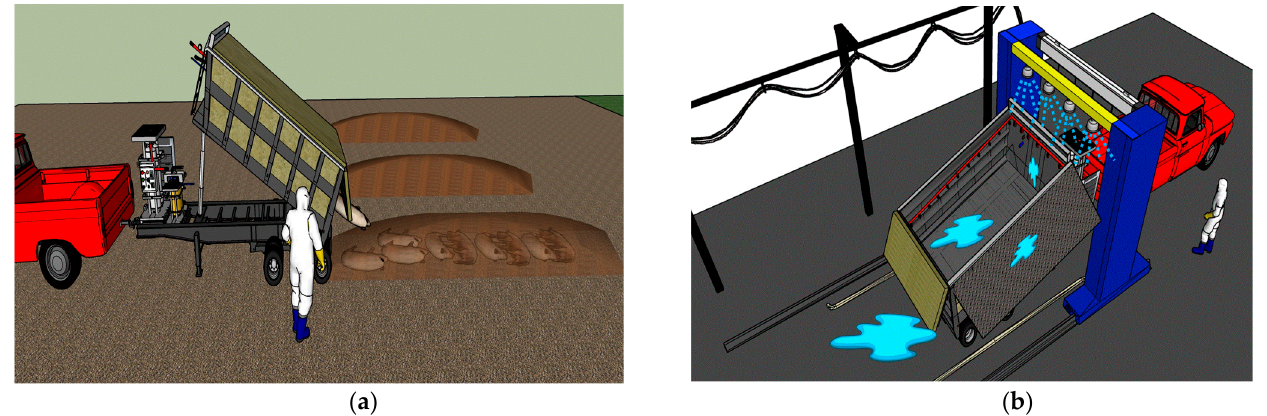
Figure 8. Unloading of treated swine carcasses at a disposal site. Design is amenable for biosecure cleanup. ( a ) Unloading of swine carcasses for off ‐ site or centralized disposal site. ( b ) Disinfection of mobile trailer to minimize the risk of spreading diseases between farms and disposal sites.